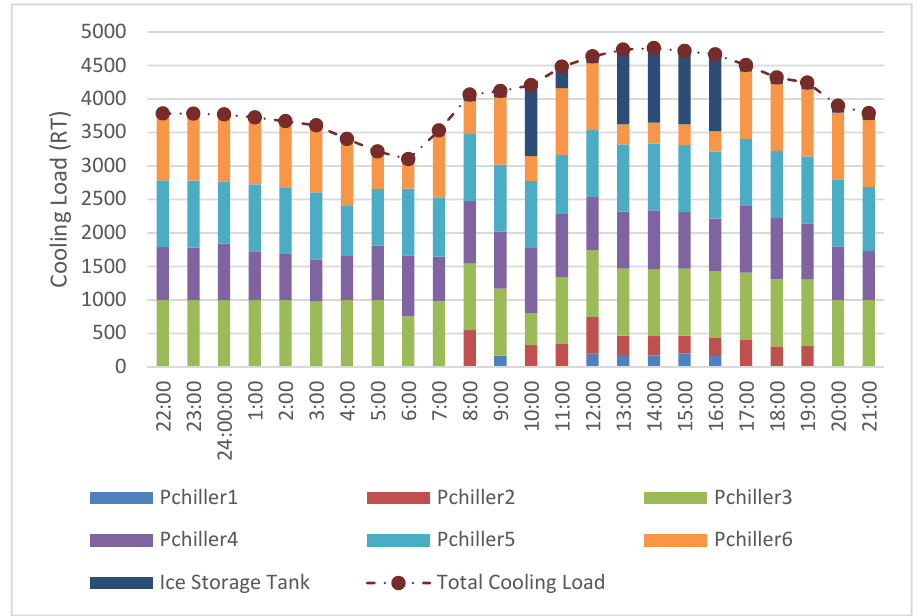
Figure 7. Cooling capability provided by each chiller and the ice storage tank on a summer day ( 16 July 2013 ).